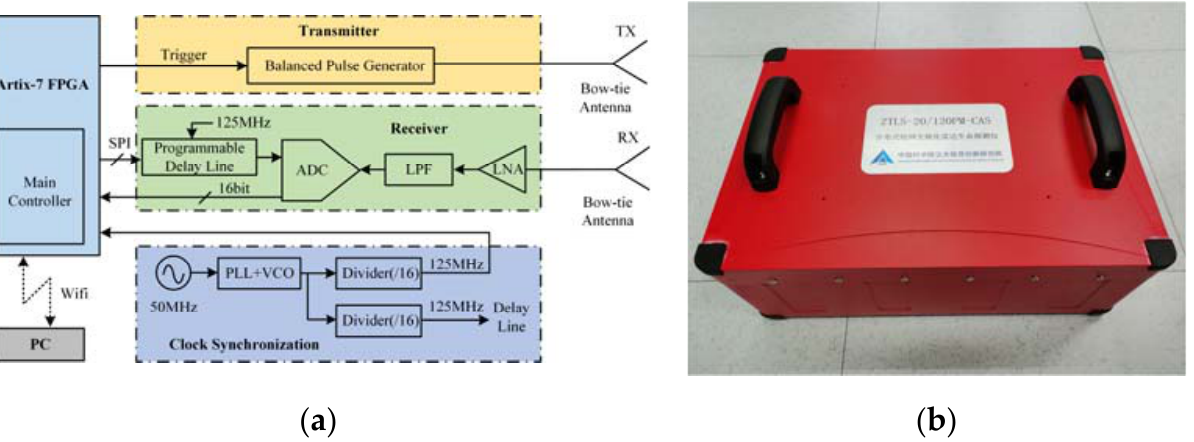
Figure 3. The block diagram and appearance photo of the used UWB impulse radar: ( a ) the block diagram and ( b ) appearance photo.